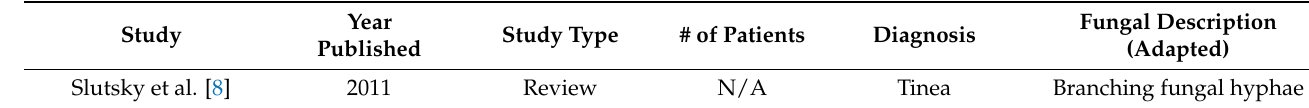
Table 2. RCM of Fungal Infections. Study characteristics and RCM descriptions summarized (N =